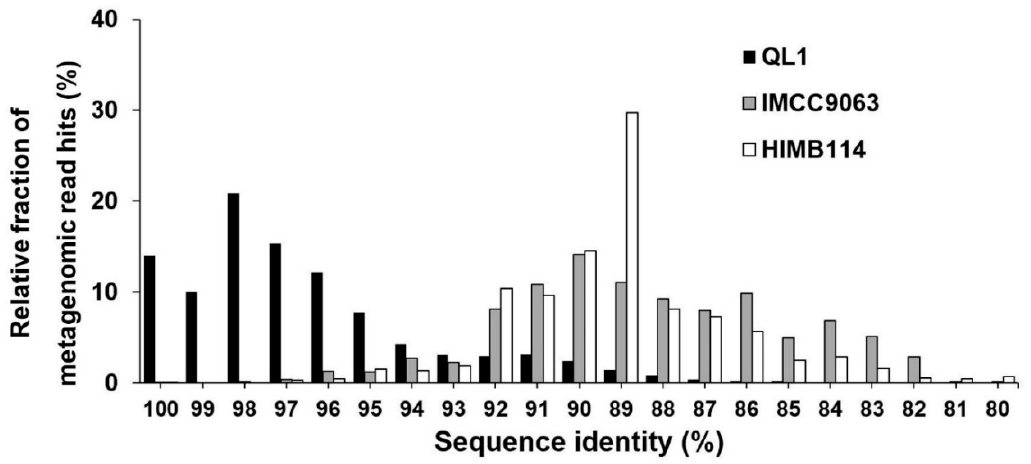
Figure 3. Intrapopulation structure of subclade IIIa. Relative fraction (y-axis) is shown at a given unit of nucleotide identity (x-axis) among the total metagenomic reads mapped on each set of marker genes (QL1, IMCC9063, and